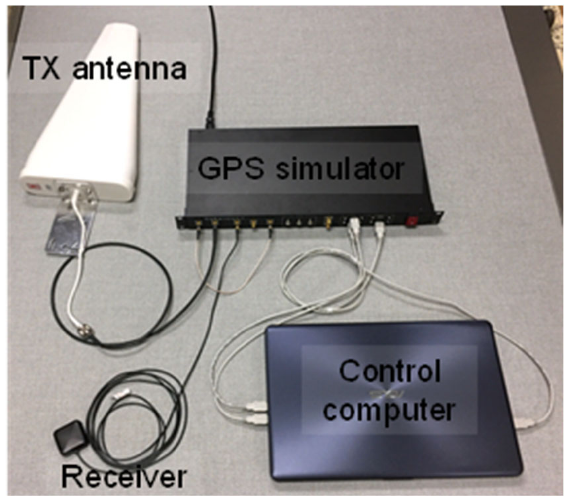
Figure 6. Configuration of GPS spoofer.